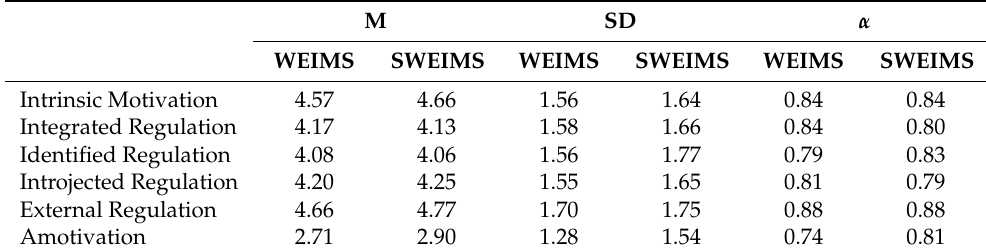
Table 2. Means, standard deviations and Cronbach’s alphas for the original Work Extrinsic and Intrinsic Motivation Scale (WEIMS) subscale scores and the Short Work Extrinsic and Intrinsic Motivation Scale (SWEIMS) subscale scores (155 construction